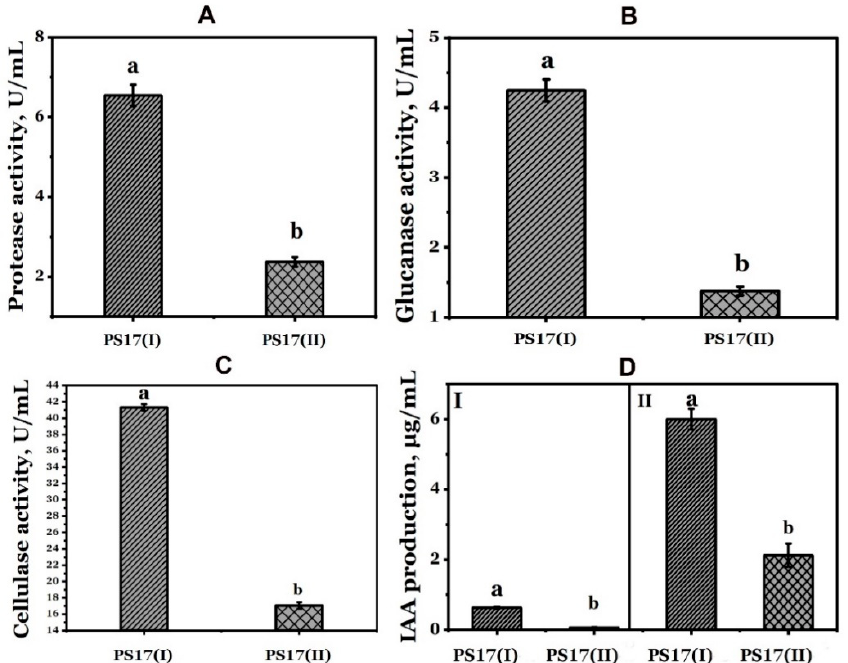
Figure 8. Effect of phenotypic variation on hydrolytic enzyme activity (( A ) protease, ( B ) glucanase, ( C ) cellulase), and ( D ) Indole-3-acetic acid production (I-without tryptophan; II-with tryptophan) of B. mojavensis PS17. The experiment was performed in triplicates and repeated twice. Statistical differences at p -value < 0.05 between groups are indicated by different letters.